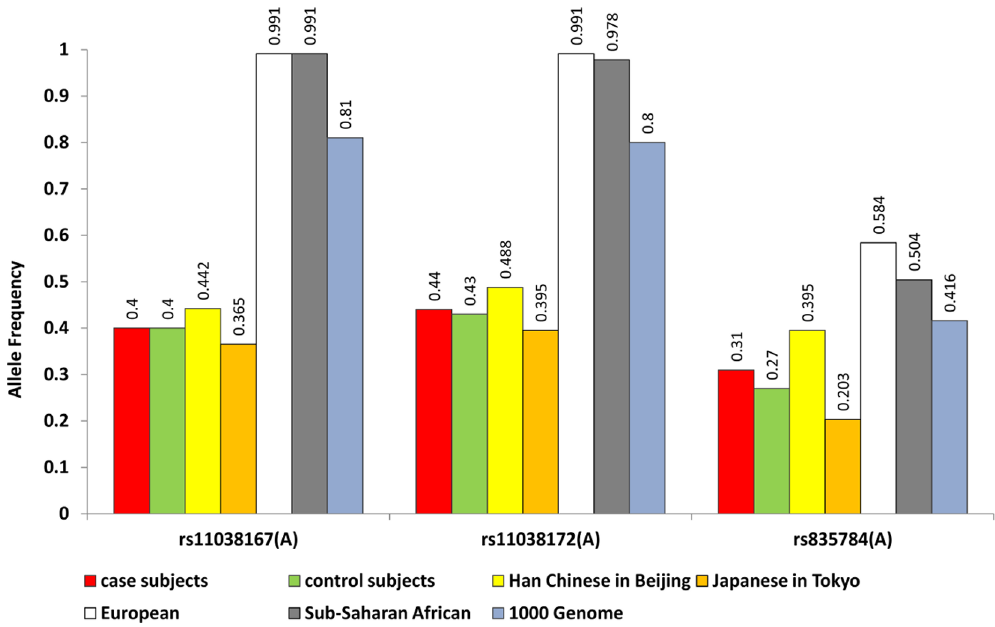
Figure 1. Allele frequency distribution among different ethnic groups for the three SNPs in TSPAN18.